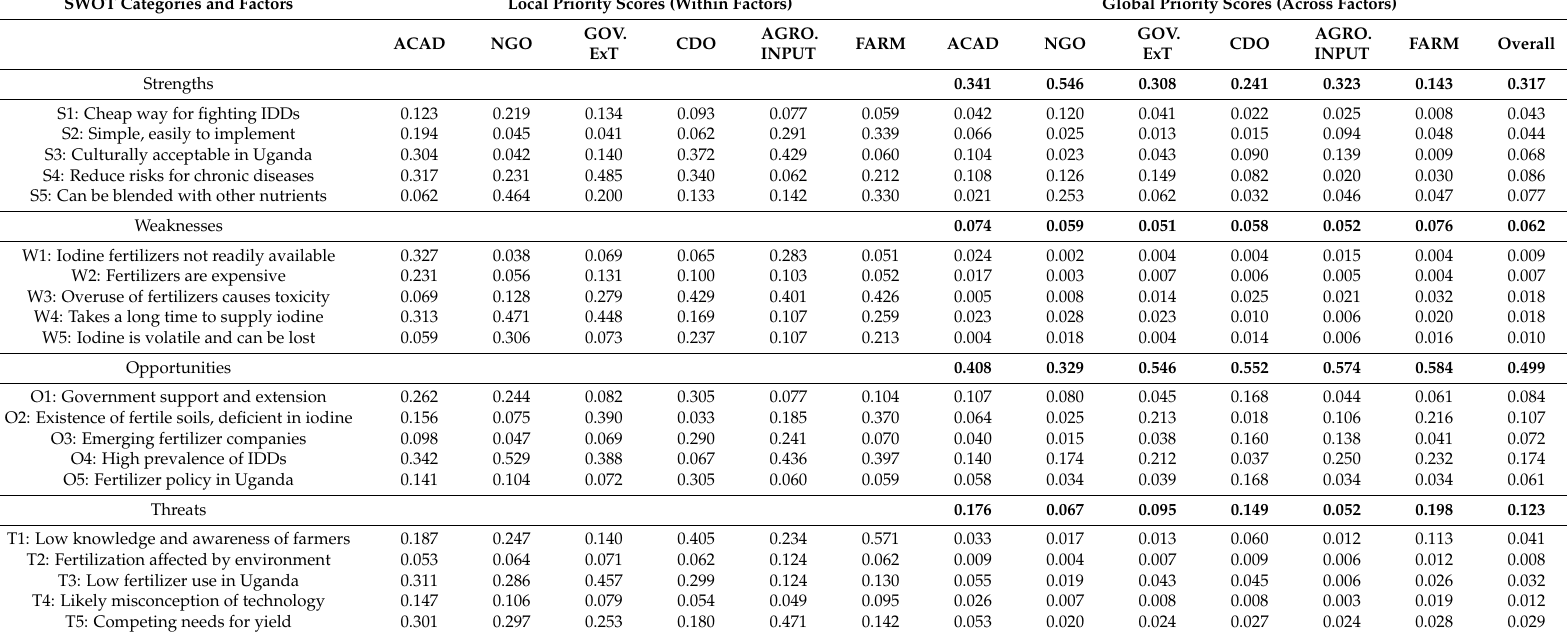
Table 3. SWOT-AHP priority scores for factors that could influence the development of agronomic iodine biofortification. SWOT Categories and